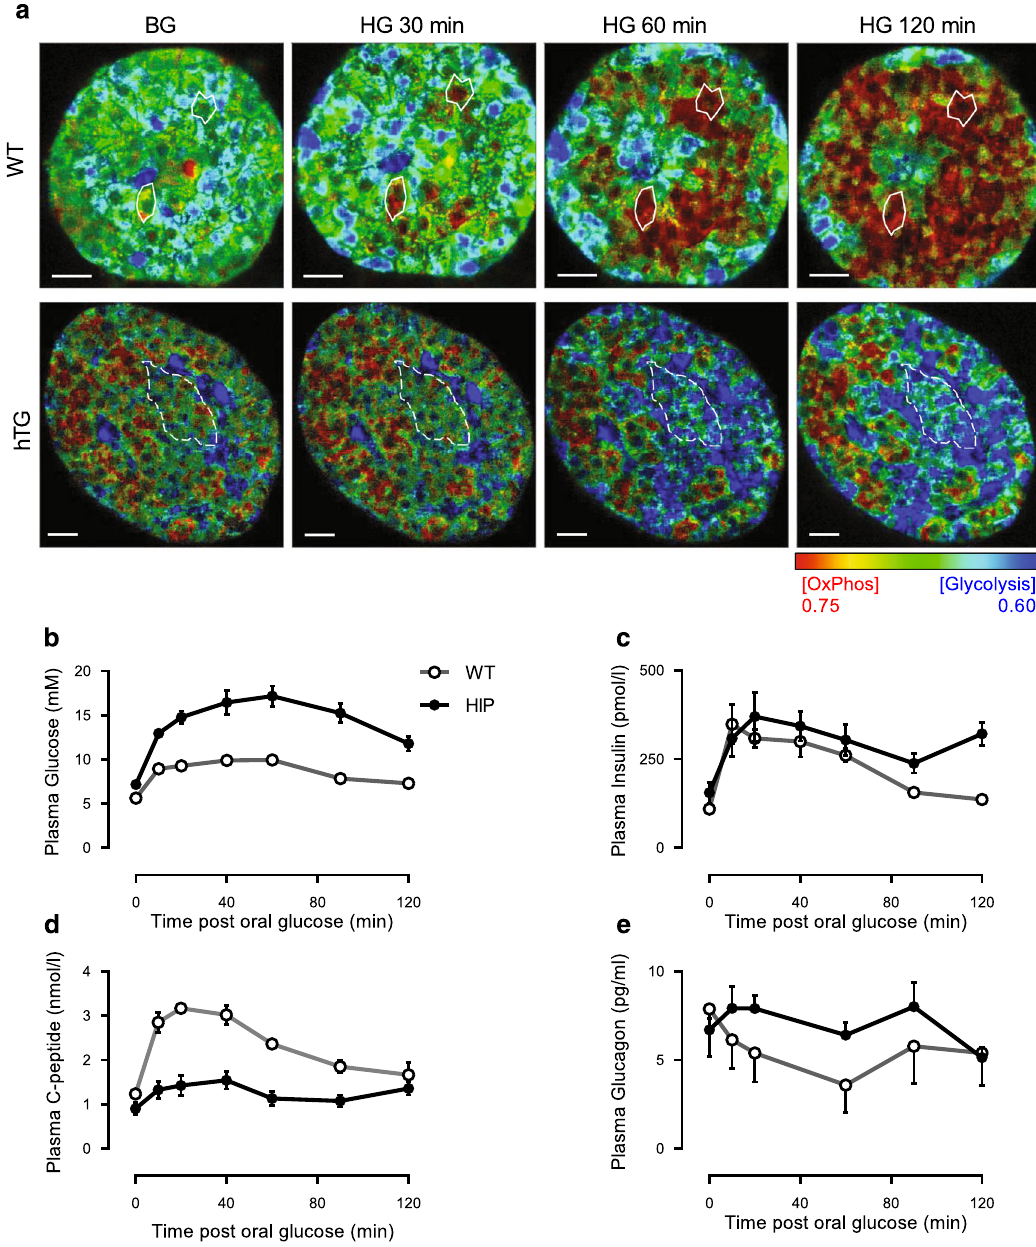
Fig. 4 Spatial temporal relationship of β cell metabolic responses to glucose in vitro and insulin and glucagon secretion in vivo in the presence and absence of misfolded protein stress. a FLIM evaluation of metabolic trajectory from representative wild type (WT) and human IAPP transgenic (hTG) mouse islets with basal glucose (BG, 4mM) and then at 30, 60 and 120min after high glucose (HG, 16mM). White solid line, hub β cells observed in WT islets; white dashed line, a cluster of adjacent β cells in hTG mice. Scale bar, 10 µ m. Plasma glucose ( b ), insulin ( c ), C-peptide ( d ), and glucagon ( e ) concentrations at baseline (min-0) and following 1.5g/kg body weight oral glucose by lavage in WT ( n = 5) and HIP ( n = 11) rats. Data presented as